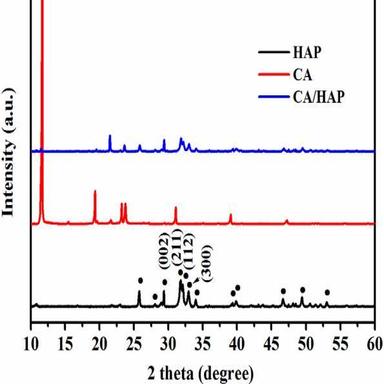
XRD patterns of HAP, CA and CA/HAP composite.